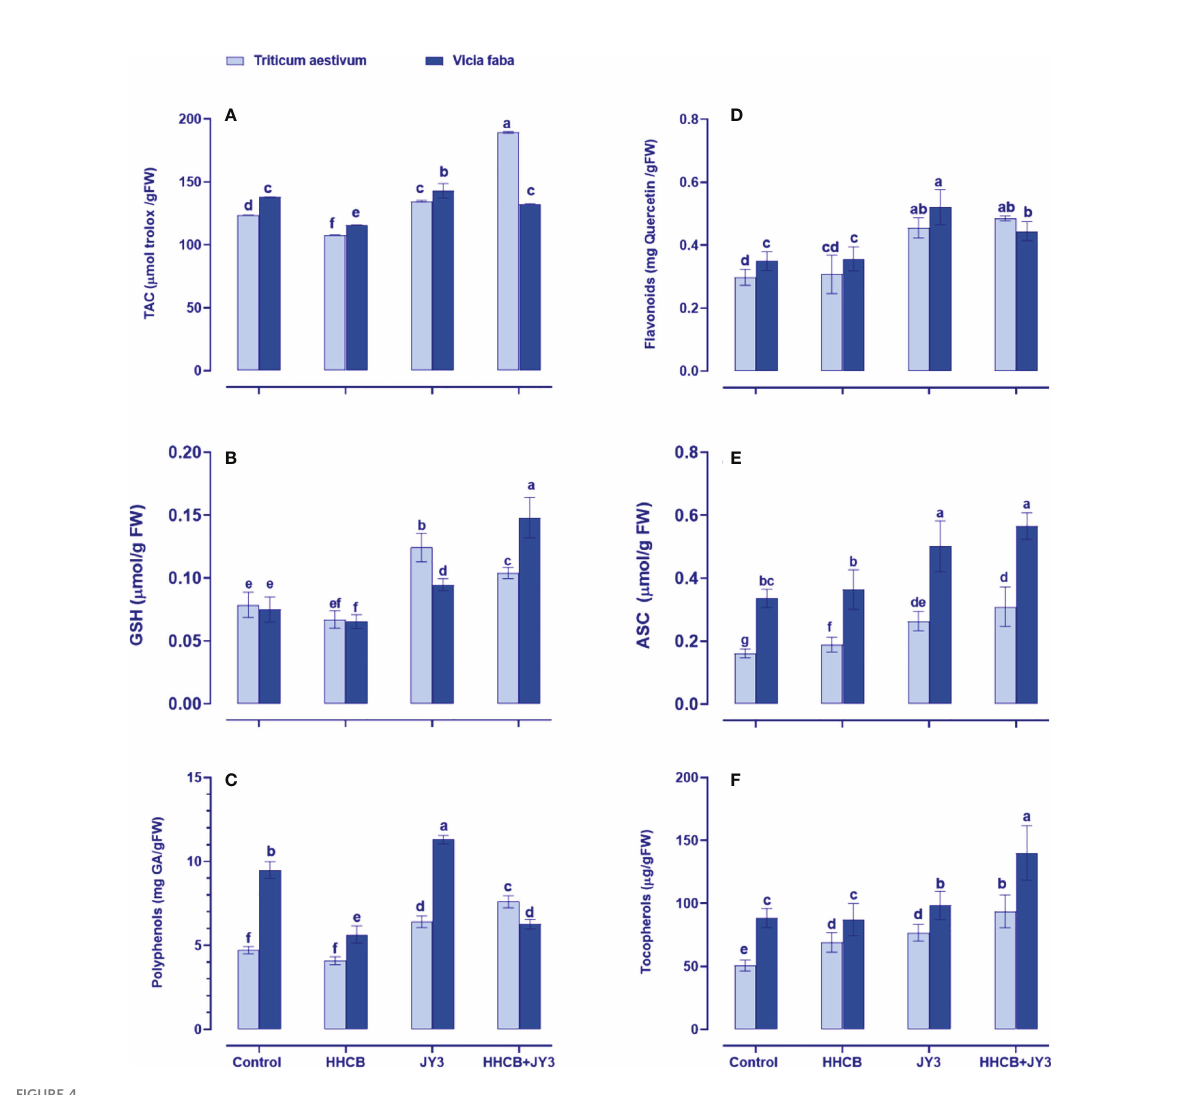
FIGURE 4 Effect of HHCB either alone or in combination with Rhodospirillum sp. JY3 on (A) the total antioxidant capacity (TAC), (B) glutathione (GSH), (C) polyphenols, (D) fl avonoids, (E) ascorbate (ASC), and (F) tocopherols of both wheat and faba beans. three biological replicates were used to detect each value. the bars on the columns represent error bars(SE). One-way ANOVA test was used to determine the signi fi cant difference between the groups. Similar letters in the bars indicate no signi fi cant dif fi dence between